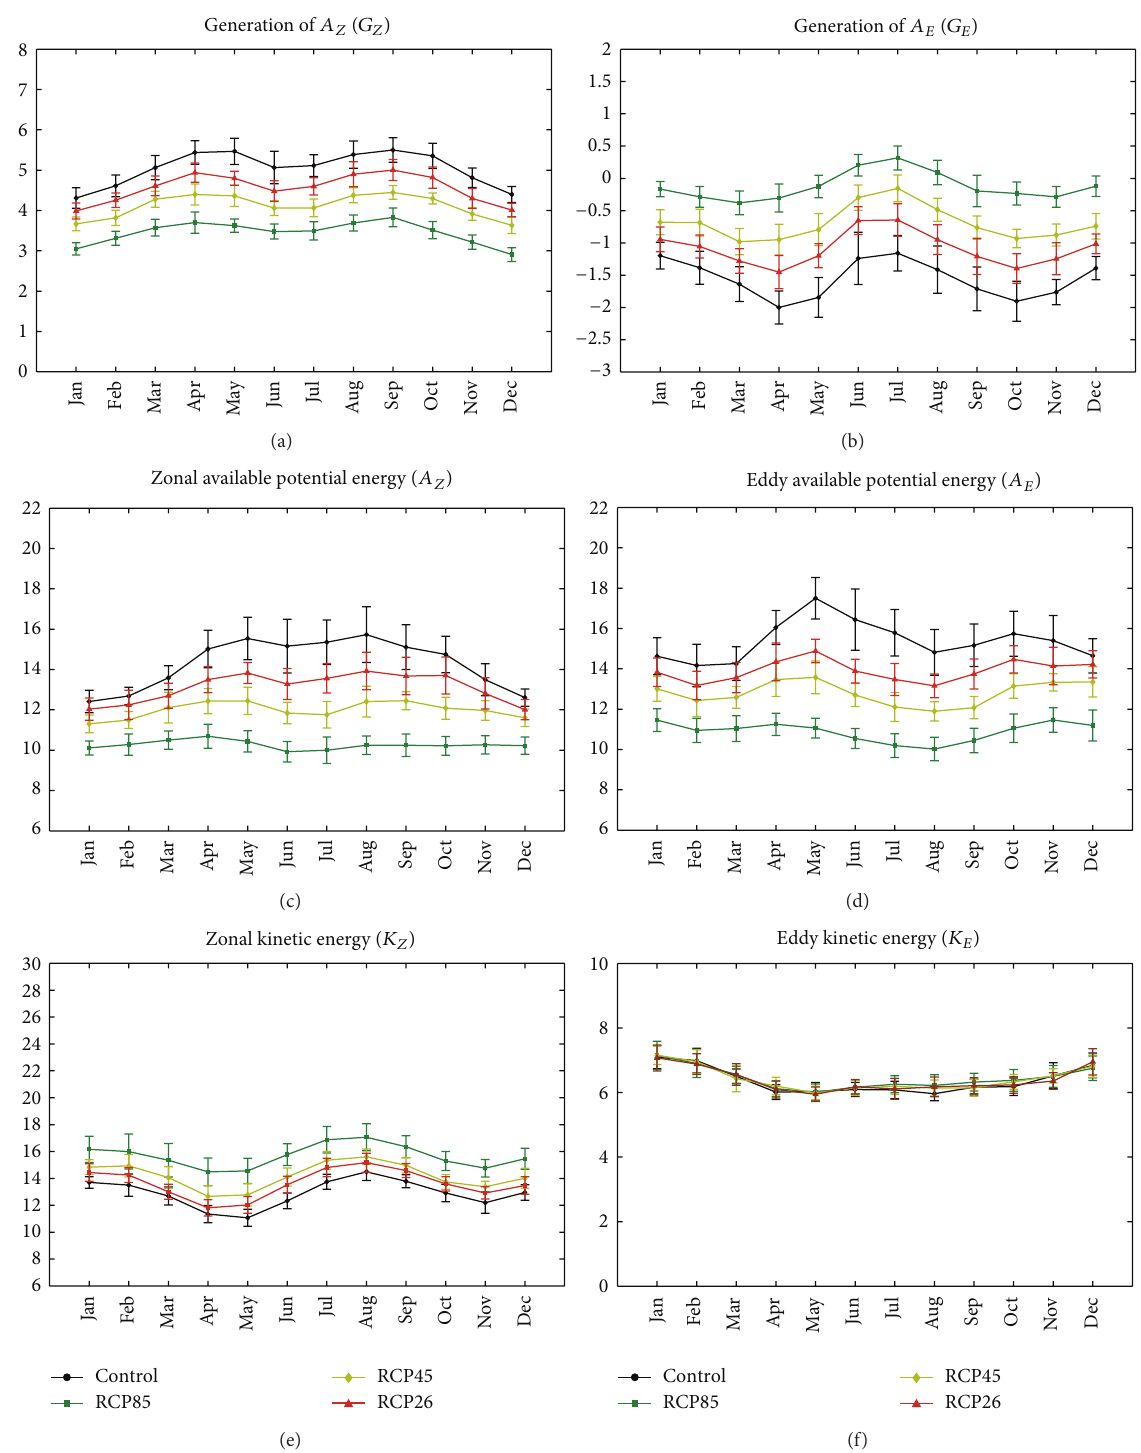
Figure 2: Climatology of the generation terms 𝐺 𝑍 (a) and 𝐺 𝐸 (b), and the energy terms 𝐴 𝑍 (c), 𝐴 𝐸 (d), 𝐾 𝑍 (e), and 𝐾 𝐸 (f) for a global domain integrated between 1000 and 1hPa for RCP85, RCP45, RCP26, and control experiments. Error bars indicate 95% confidence intervals about the mean. Units are 10 5 J/m 2 for reservoirs and W/m 2 for generation